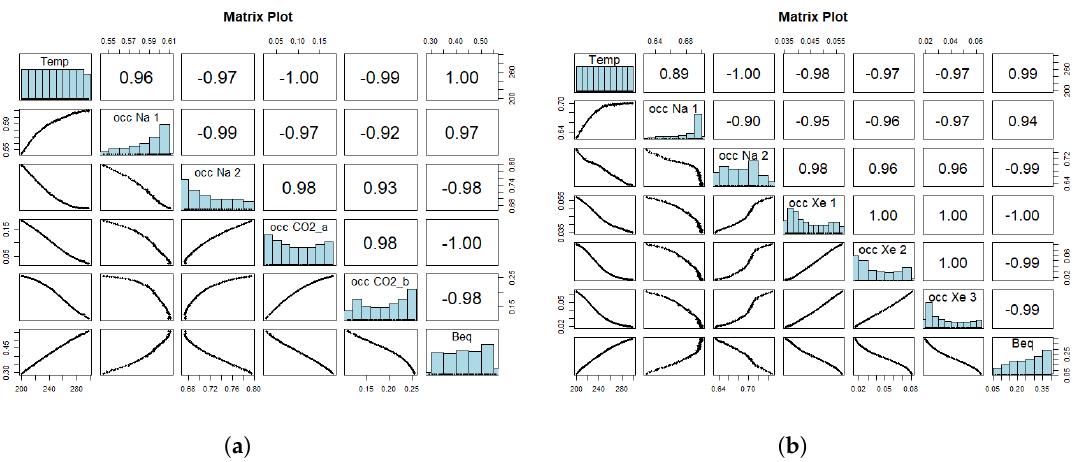
Figure 9. Matrix scatter plot: bivariate scatter plots below diagonal, histograms on diagonal, and Pearson correlation above diagonal. Considered variables were sodium and gas occupancy, and framework thermal factors refined by Rietveld analysis for CO 2 ( left ) and Xe ( right ). (e.g., element of matrix plot of CO 2 [4,2] and [2,4] are, respectively, scatter plot and Pearson correlation of Occ Na1 and Occ CO 2 1). Matrix plots of ( a ) CO 2 and ( b ) Xe data.